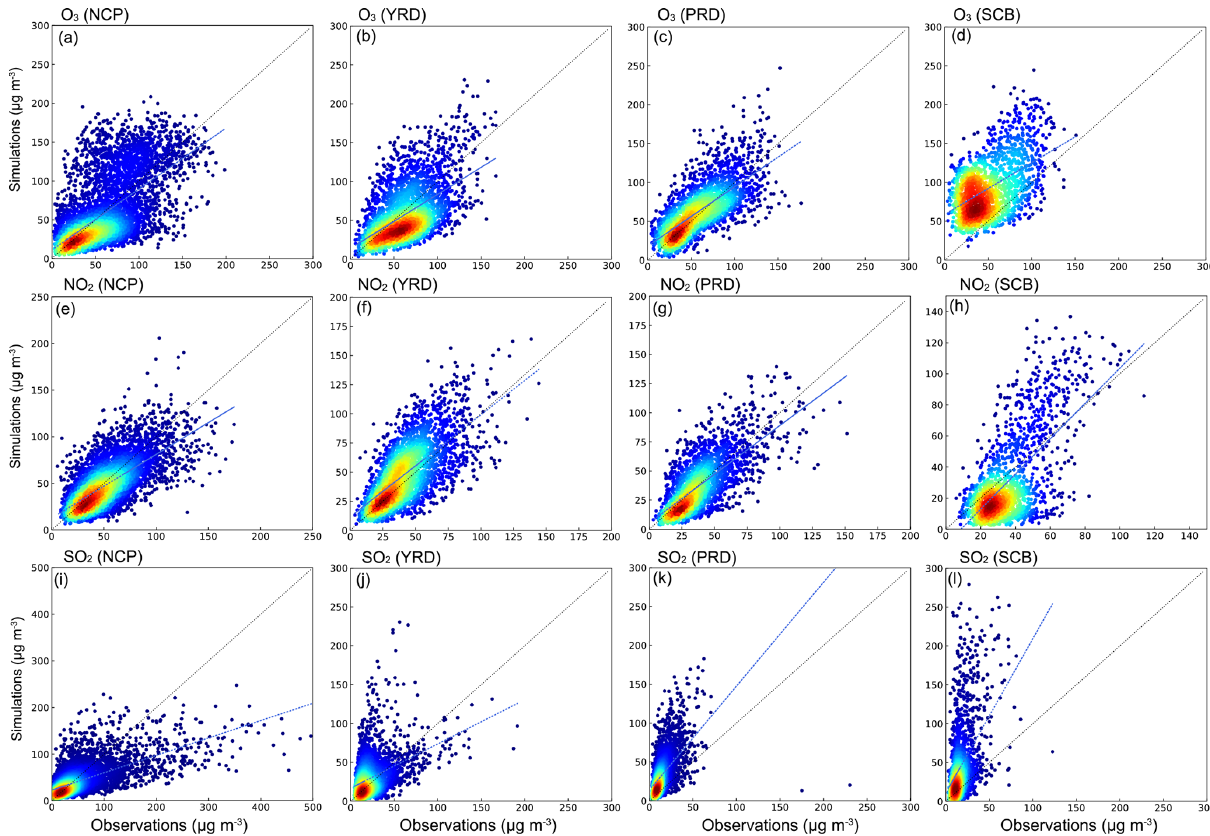
Figure 4. Scatter plots of modeled and observed hourly concentrations of (a–d) O 3 , (e–h) NO 2 , and (i–l) SO 2 in the NCP, YRD, PRD, and SCB